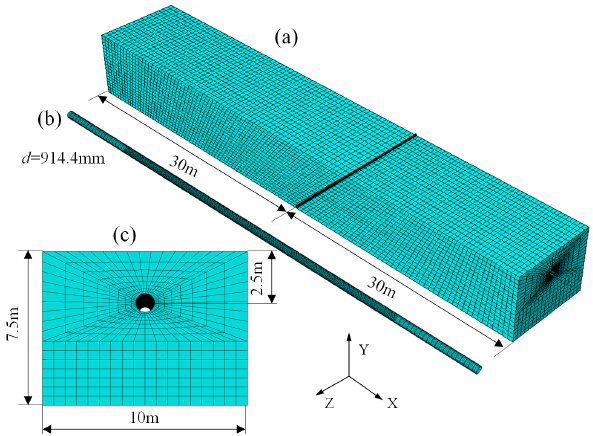
Figure 1. Finite element model. (a) The whole model, (b) the buried pipeline and (c) cross section of the model.